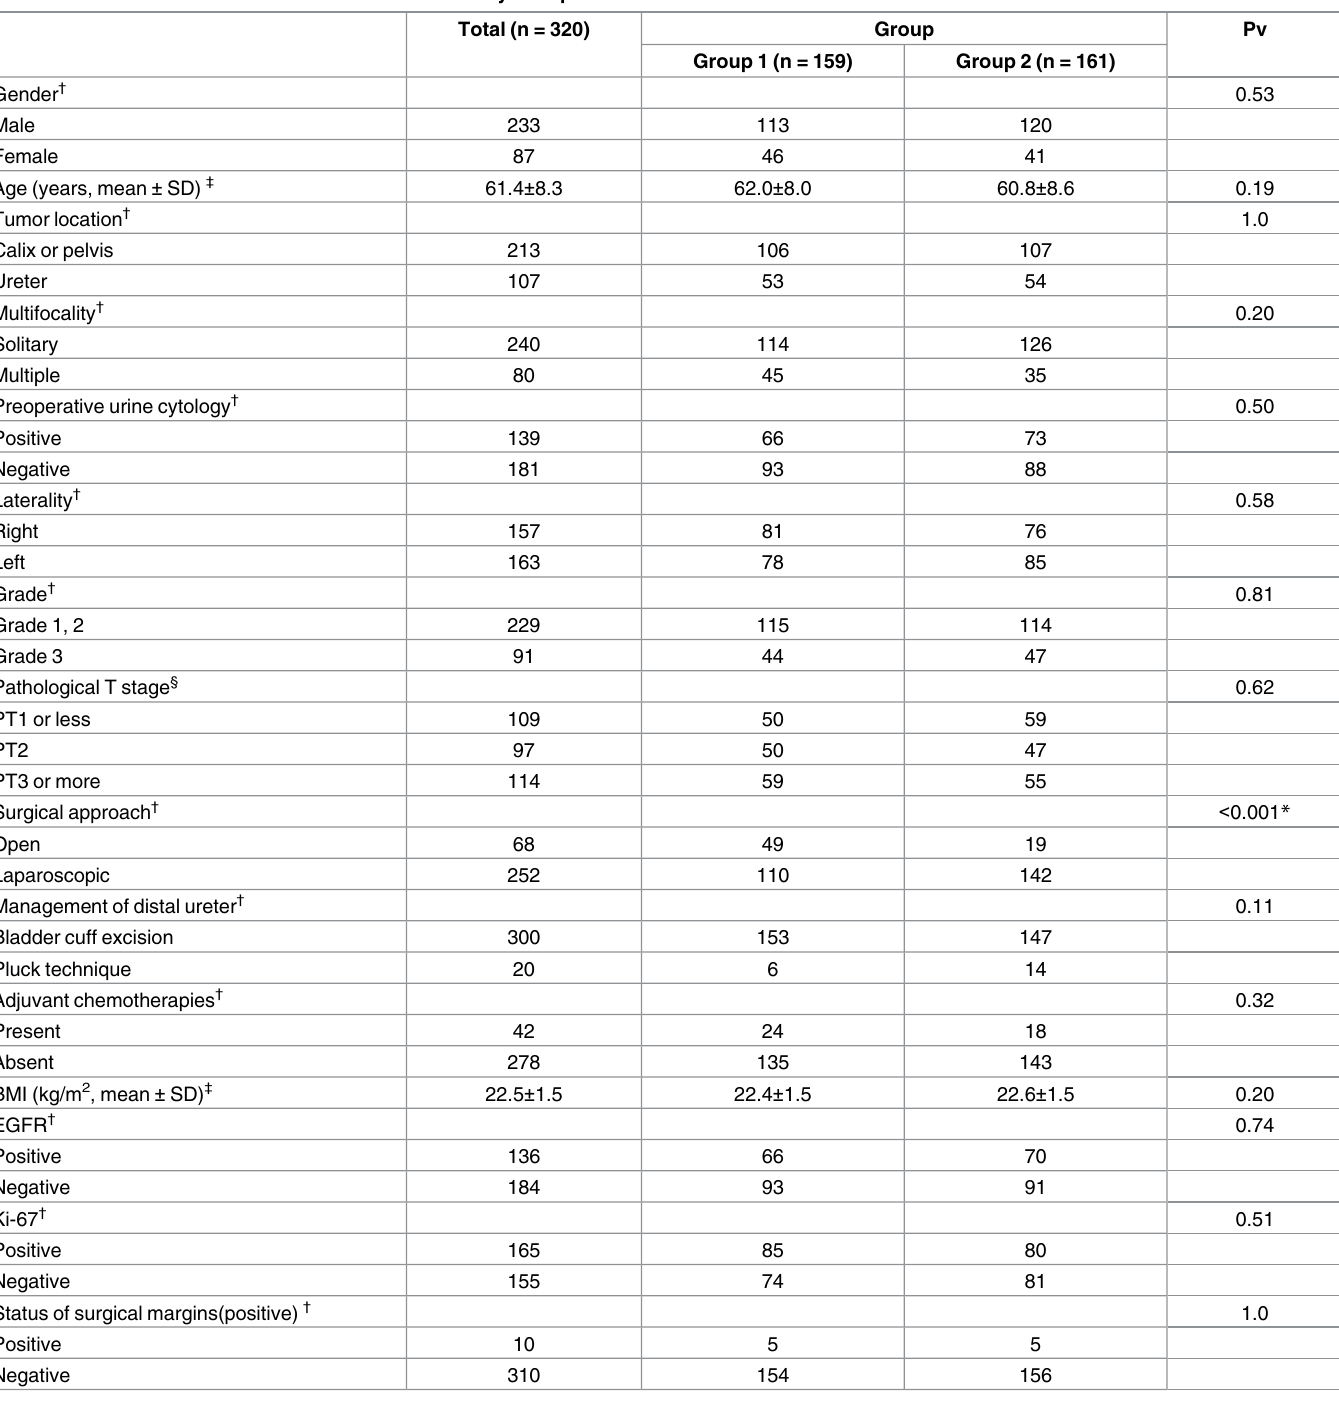
Table 1. Patient and Tumor Characteristics Stratified by